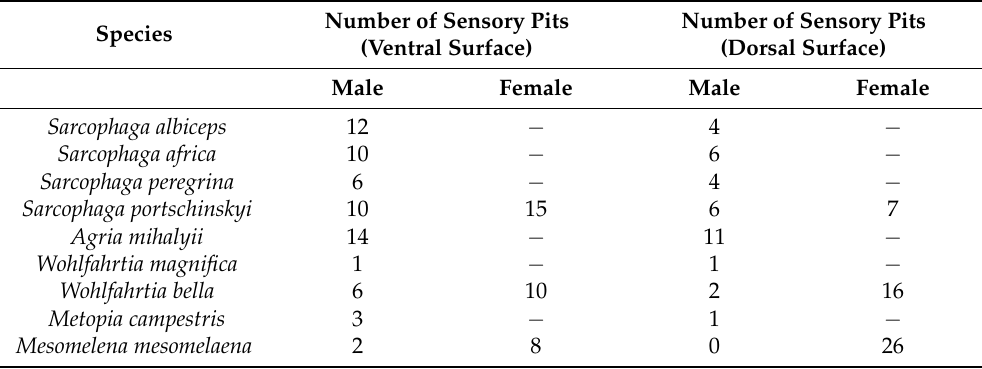
Table 1. The number of sensory pits on the dorsal and ventral surfaces of the postpedicel of nine examined species. ( − = undetermined, n = 1). Number of Sensory Pits Number of Sensory Pits Species (Ventral Surface) (Dorsal Surface) Male Female Male Female Sarcophaga albiceps −